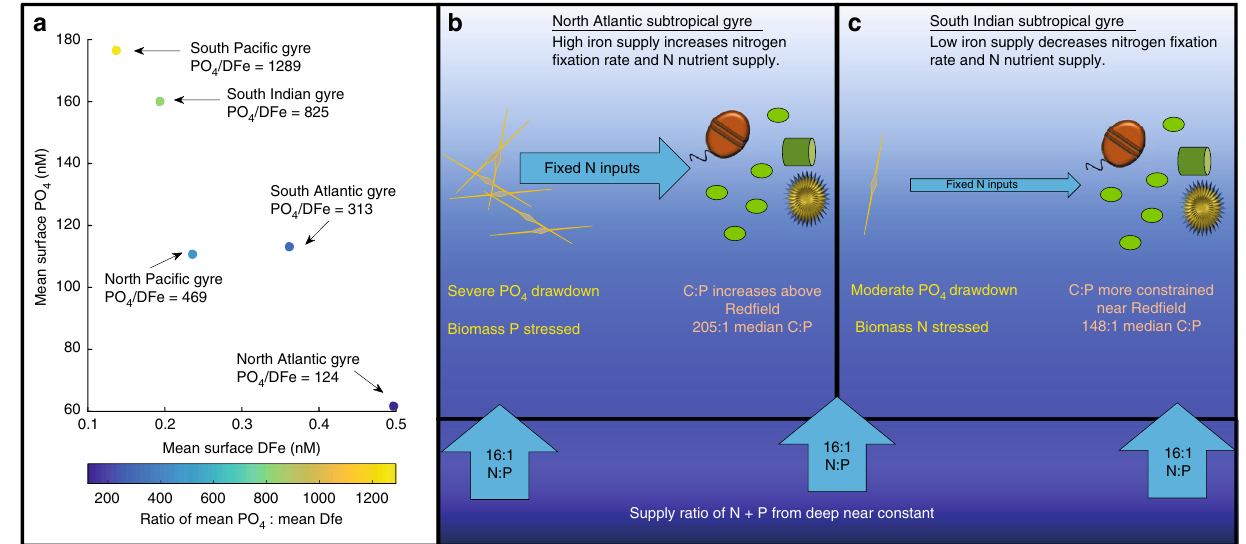
Fig. 7 Conceptual model for regulation of ocean gyre biogeochemistry. a Nutrient levels across gyres: median surface phosphate to dissolved iron in top 50 m. b Iron supply model for C:P in North Atlantic and c South Indian Ocean subtropical gyres. Median C:P values are from gyre comparison (North Atlantic, Supplementary Table 6) and this